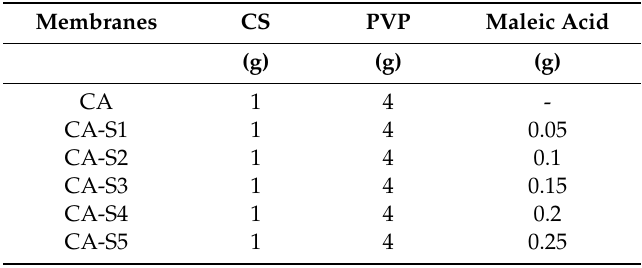
Table 3. Weight ratios of chitosan (CS), poly (vinylpyrrolidone) (PVP), and maleic acid for varying membrane compositions. Membranes CS